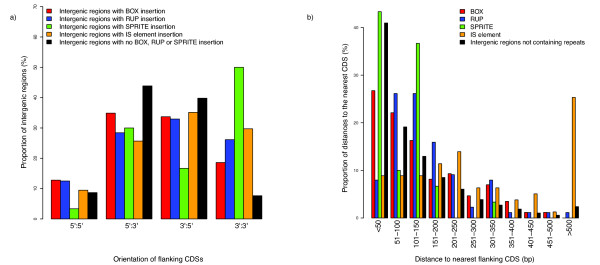
Distribution of repeat sequences within the S. pneumoniae ATCC 700669 genome. a) The orientation of the CDSs flanking different repeat elements. Data are shown for BOX, RUP, SPRITE and IS elements annotated in the chromosome; the black bars indicate the orientations of all neighbouring CDSs in the genome not separated by intervening small interspersed repeats. b) A comparison of the distance from repeat sequences, including IS elements, to the nearest CDS, and the distribution of lengths of intergenic sequences not containing repeats.